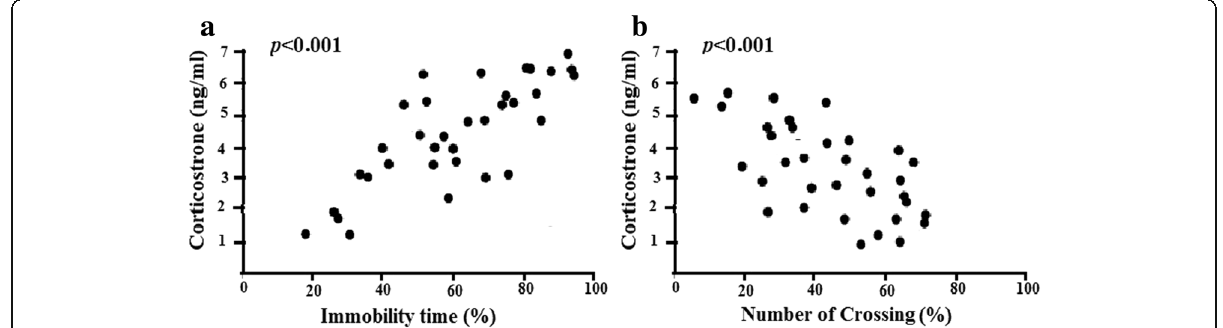
Fig. 3 The behavioral results were correlated with relevant biological outcomes. Panel ( a ) shows the correlation between the immobility time in OFT and hippocampus corticosterone content. Panel ( b ) shows the correlation between the number of crossing in OFT and hippocampus corticosterone